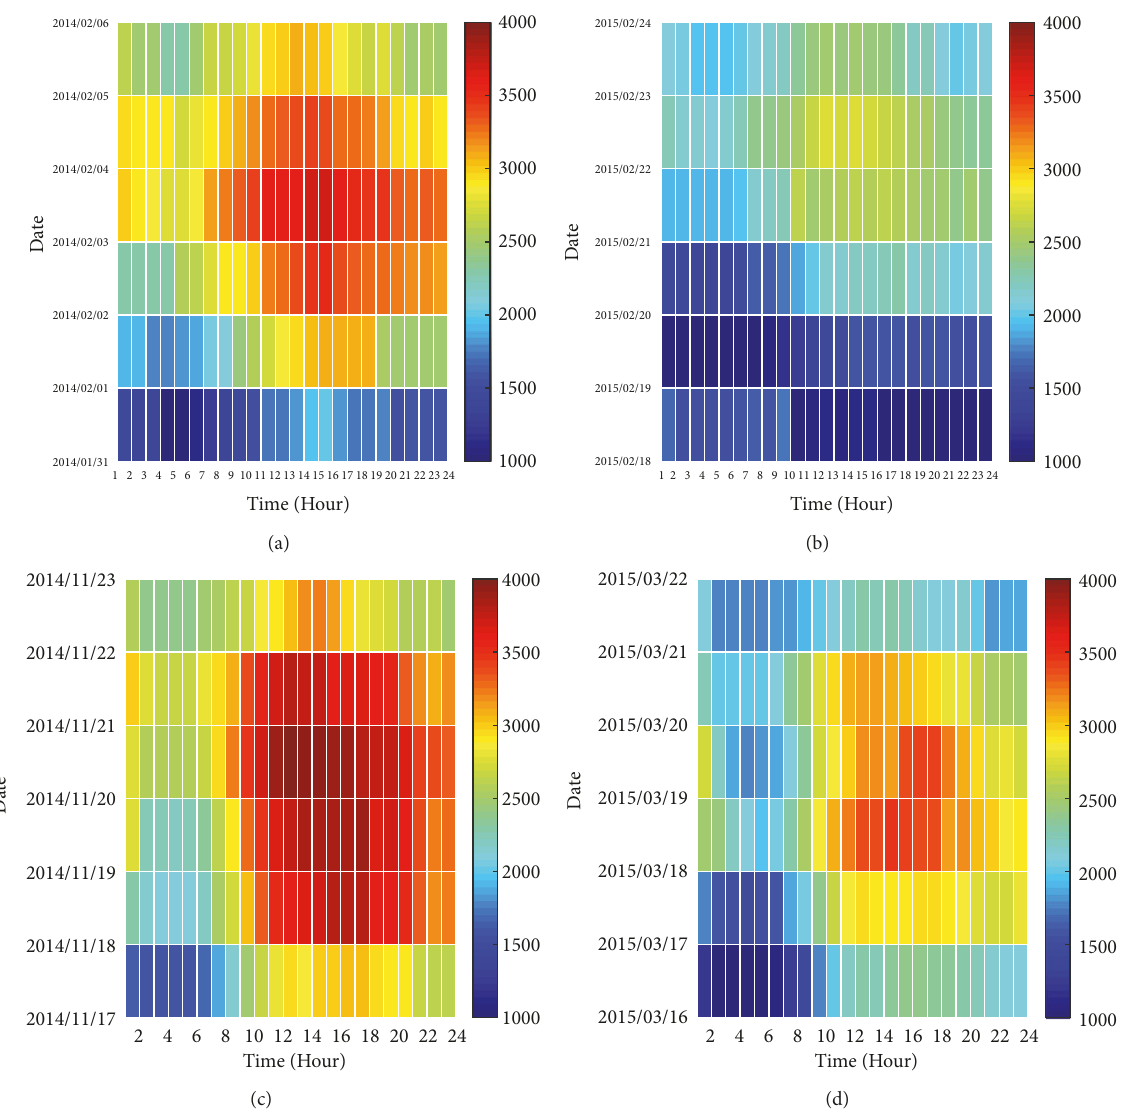
Figure 2: The occupancy of the Hongqiao Terminal 2 parking lot: (a) the occupancy during the Spring Festival before price adjustment; (b) the occupancy during the Spring Festival after price adjustment; (c) the occupancy during an ordinary week before price adjustment; (d) the occupancy during an ordinary week after price